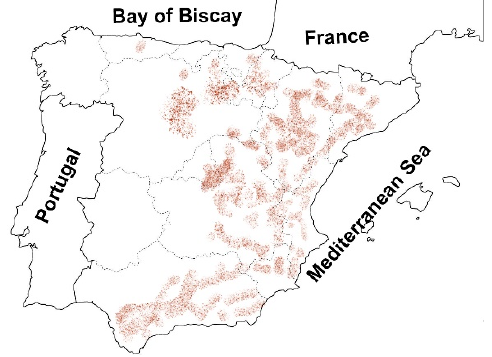
Figure 1. Native gypsum bearing soils in Spain (adapted from [17]).